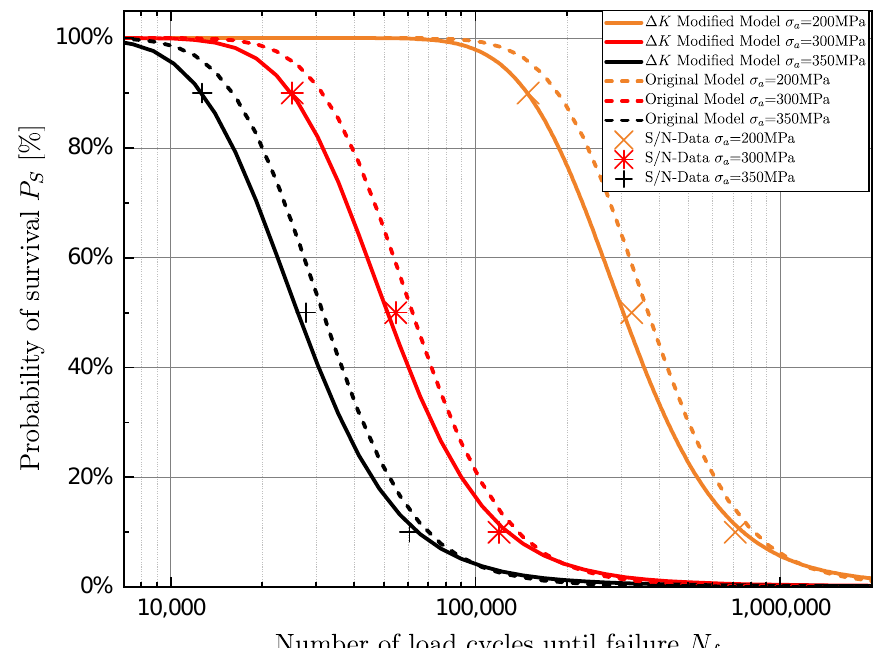
Figure 10. Model validation for constant stress